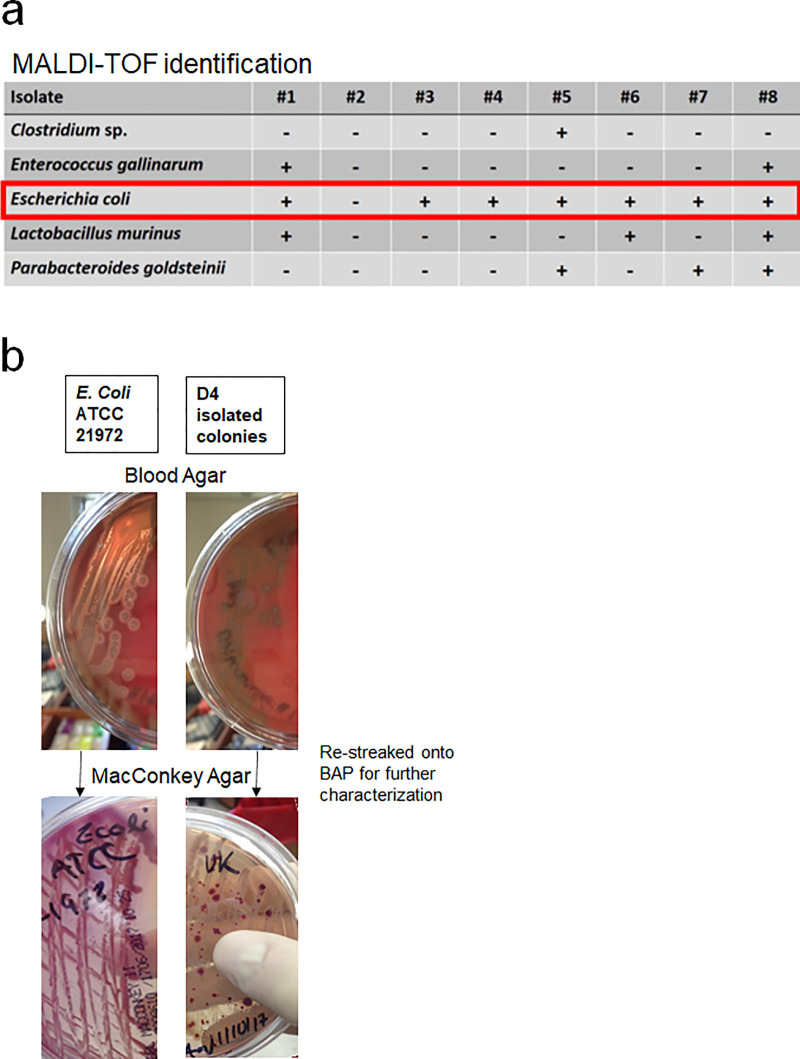
Isolation of family Enterobacteriaceae.A) MALDI-ToF identification of D4 PI fecal samples. B) Blood Agar and MacConkey Agar plates comparing colony morphology, hemolytic properties, and lactose fermentation of lab strain ATCC 21972 E. coli and unknown D4 isolated E.coli strain.